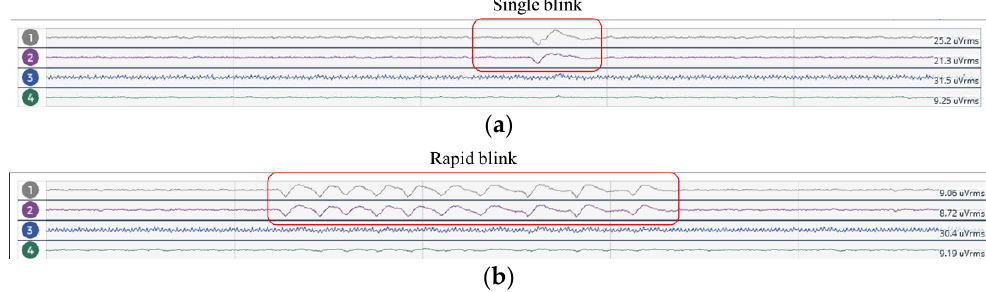
Figure 9. EEG response to the eye blinking test. ( a ) Single blink; ( b ) rapid blink.